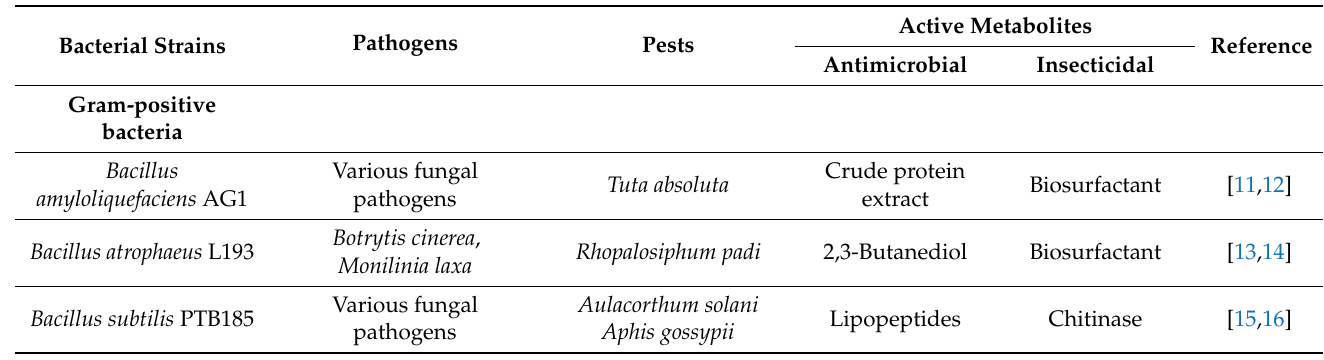
Table 1. Rhizosphere bacteria that protect plants against multiple pests (i.e., microbes, insects, and nematodes) through characterized metabolites and